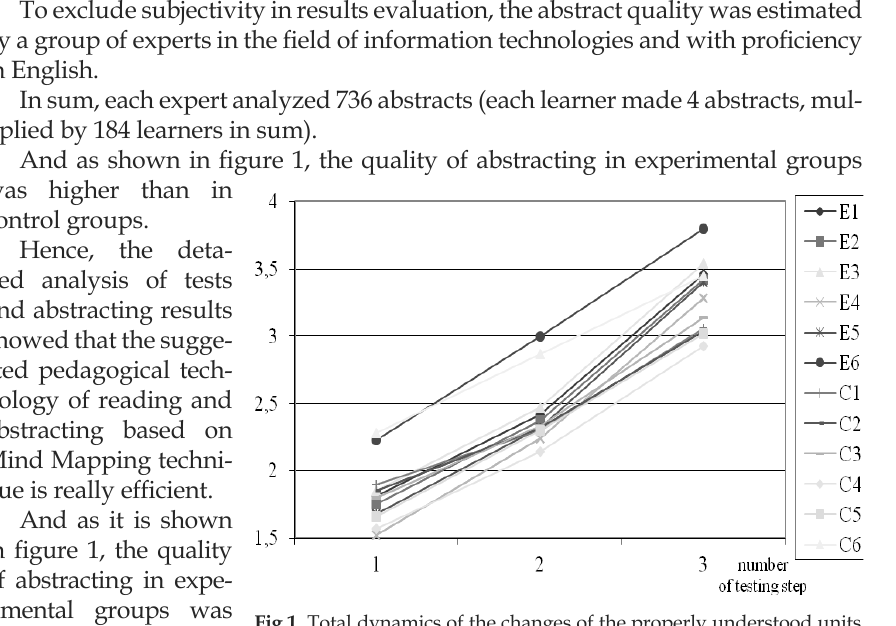
Fig.1. Total dynamics of the changes of the properly understood units coef (cid:222) cient. Source: own